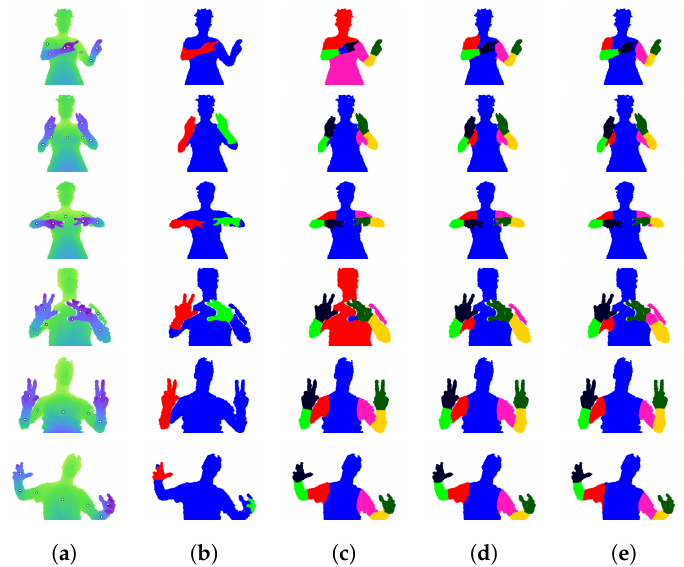
Figure 7. Dataset 1 [4]: Qualitative results. ( a ) Depth image with annotated part positions. ( b ) Arm segmentation. ( c ) Standard RW segmentation. ( d ) Our method without line seed pixels. ( e ) Our method with line seed